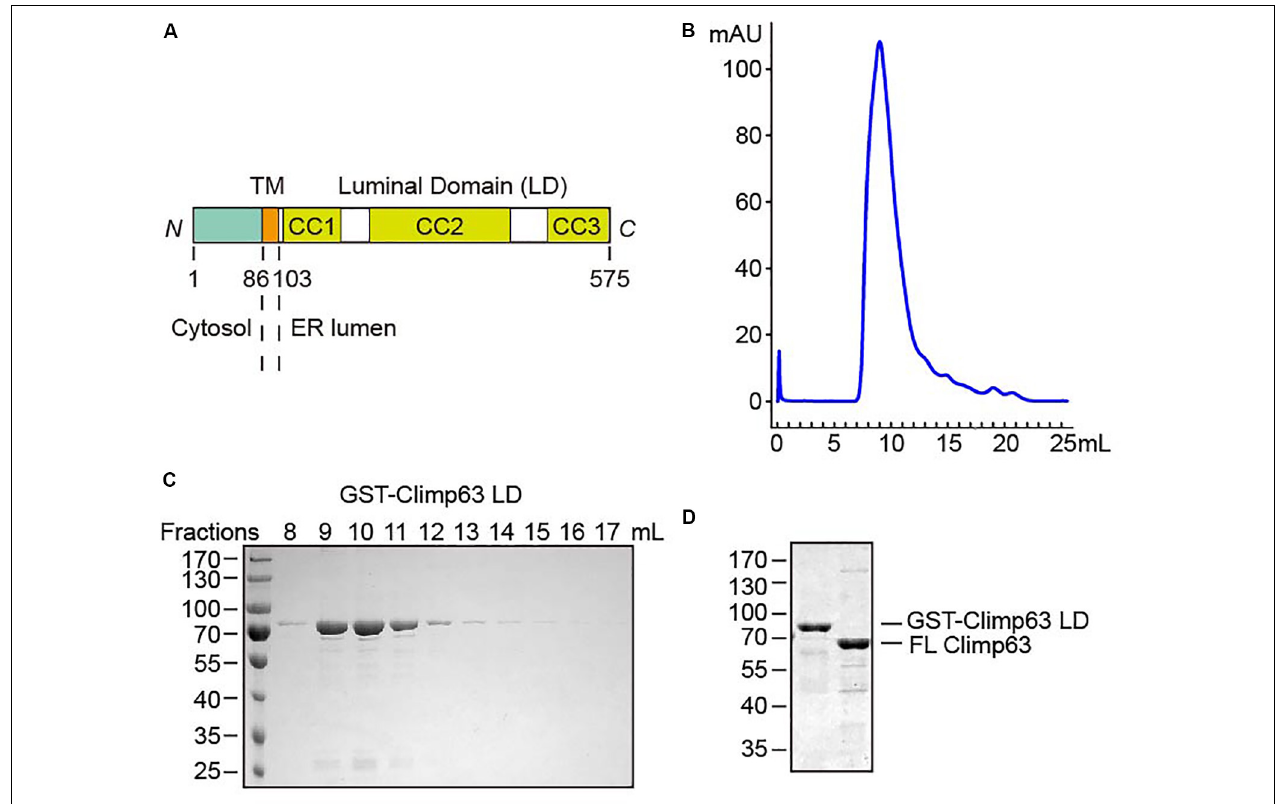
FIGURE 1 | Purification of Climp63. (A) Schematic diagram of M. musculus Climp63. The amino acids are numbered. TM, transmembrane; CC, coiled coil. (B) GST-Climp63 LD was purified through gel filtration analysis. (C) After gel filtration, the fractions were analyzed by SDS-PAGE and Coomassie blue staining. (D) GST-Climp63 LD and FL Climp63 were purified and the samples were analyzed by SDS-PAGE and Coomassie blue